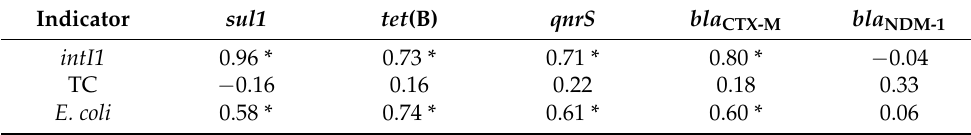
Table 3. Pearson’s correlation coefficient between intI1 , ARGs, and fecal indicator bacteria.